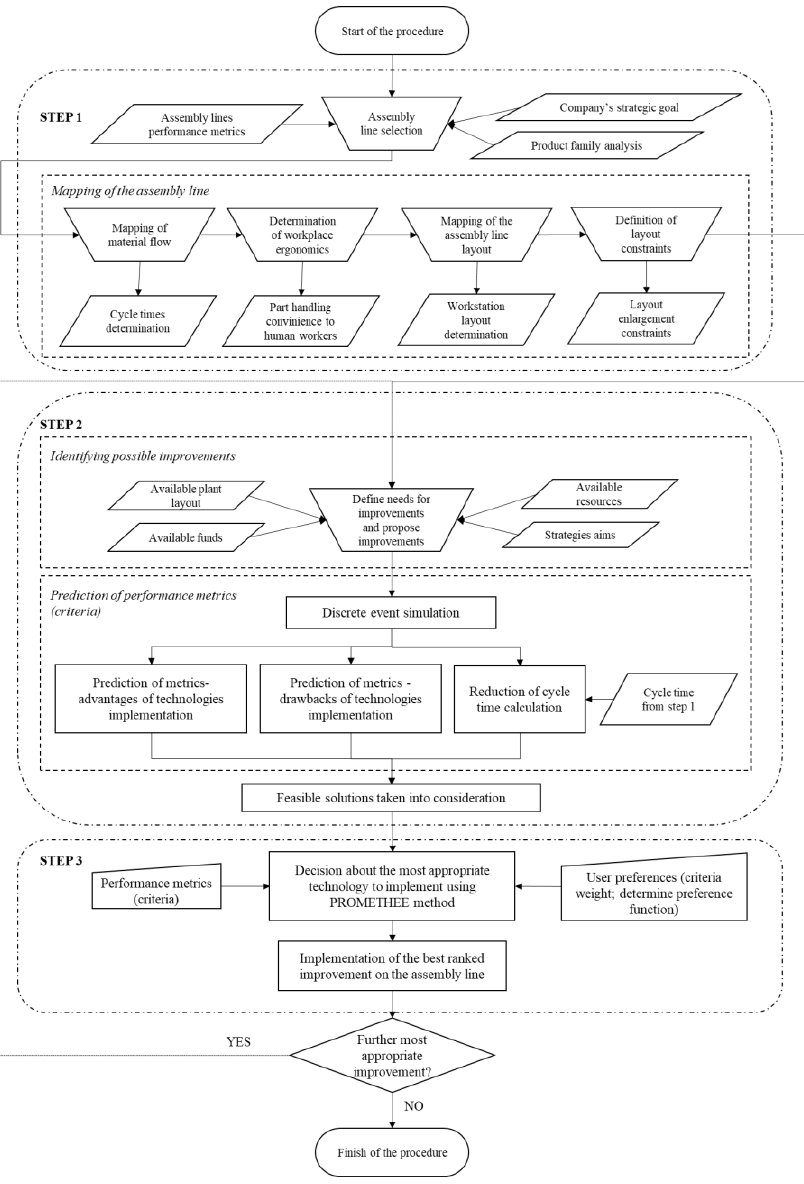
Figure 1. The proposed procedure for the evaluation of the most appropriate technology to implement.